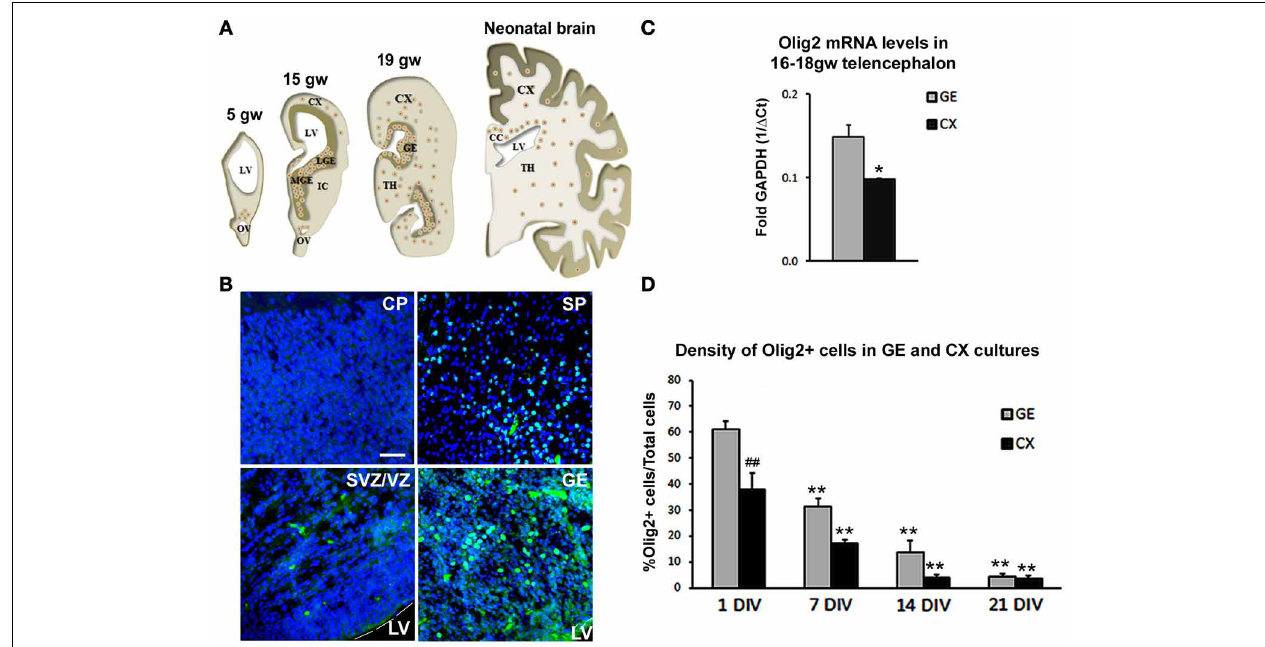
FIGURE 1 | Olig2 expression in the human fetal forebrain. (A) Schematic representation of the distribution of Olig2 + cells (red dots) in frontal sections of the fetal (5–19gw) and neonatal human telencephalon. (B) Representative Olig2 (green) immunostaining in 15gw fetal forebrain. Nuclear staining with bisbenzimide (BB) in blue. (C) RT-PCR levels for mRNA Olig2 in CX and GE in 16–18gw human brains. Data are presented as mean ± standard deviation. (D) Percentage of